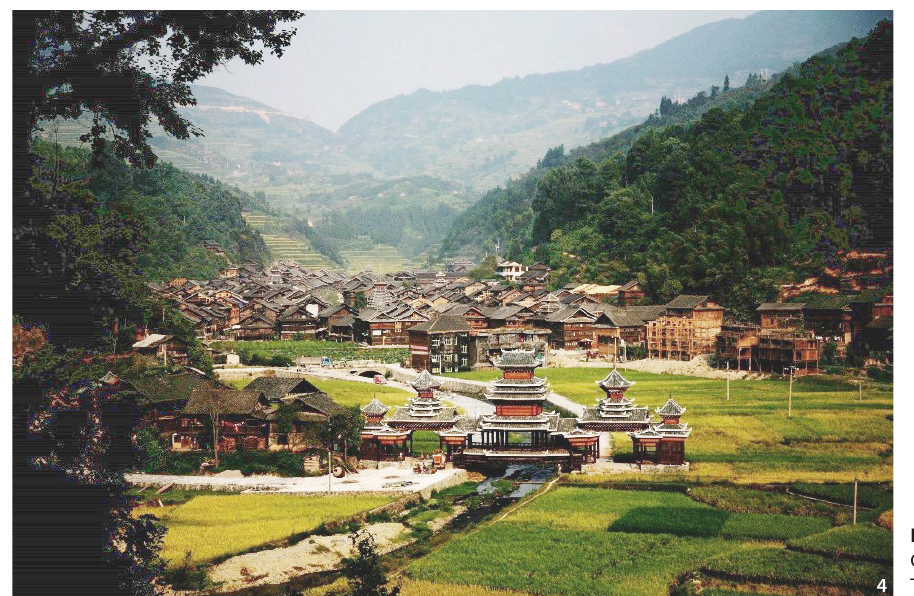
Figure 4 Zhaoxing, Dong Village, Guizhou (Source: Guizhou Zhaoxing Travel Guide, Chian Discovery) 7 .